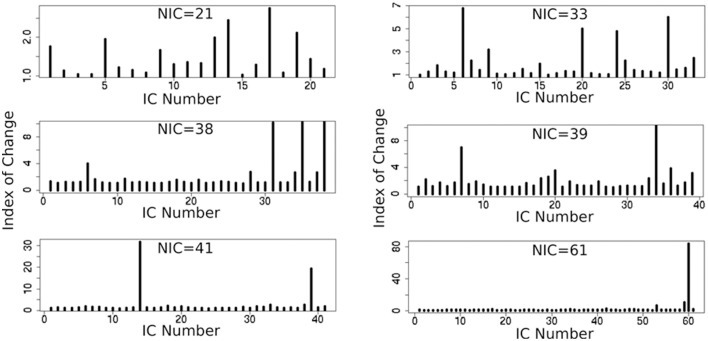
Cross-sectional plots of change index of spatial overlap and temporal association (CISOTA) for all ICs at different 6 NICs.